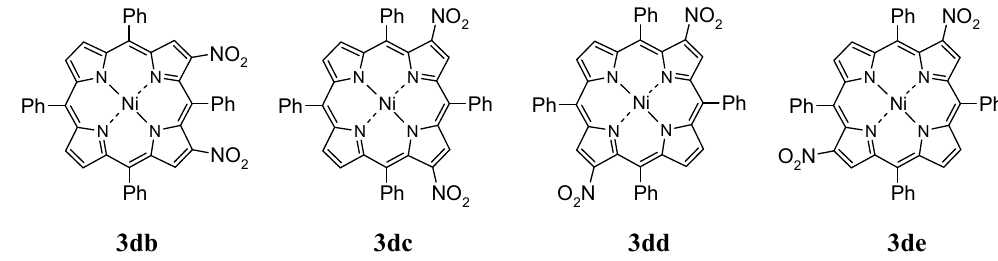
Figure 2. Structures of 3db , 3dc , 3dd , and 3de .